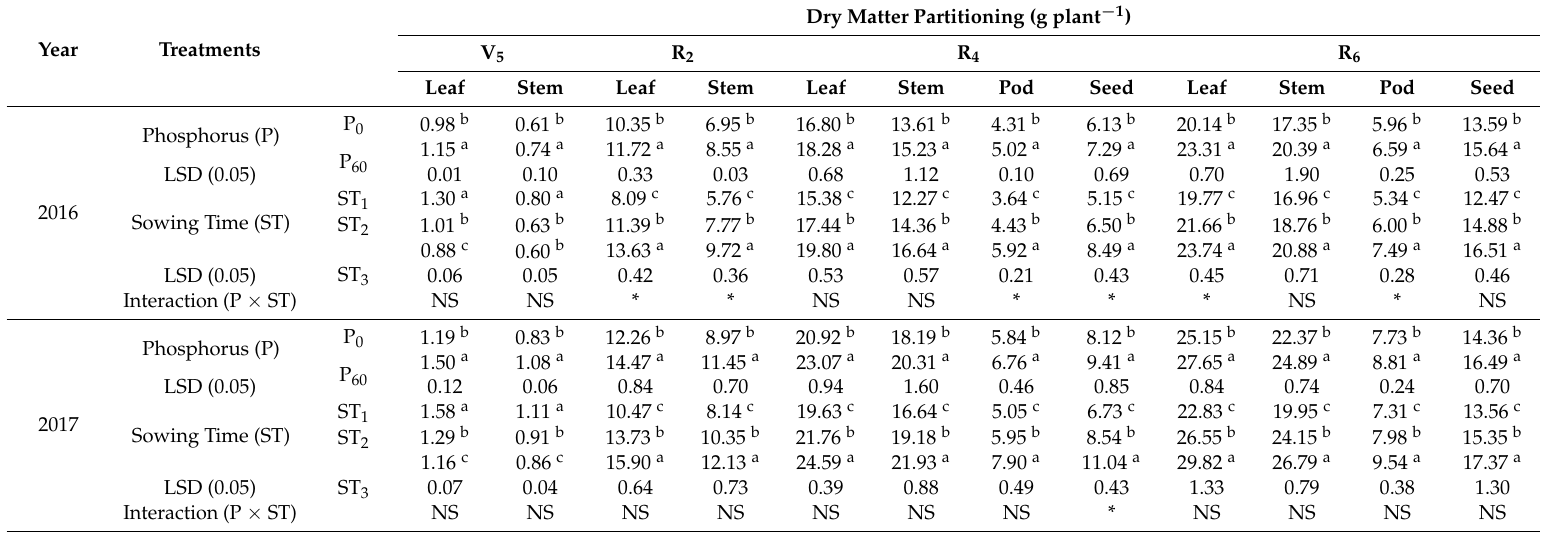
Table 4. Effect of sowing times and phosphorus fertilizer rates on above ground dry matter partitioning of soybean at four stages of phenological development in relay intercropping system with maize during the cropping seasons of 2016 and